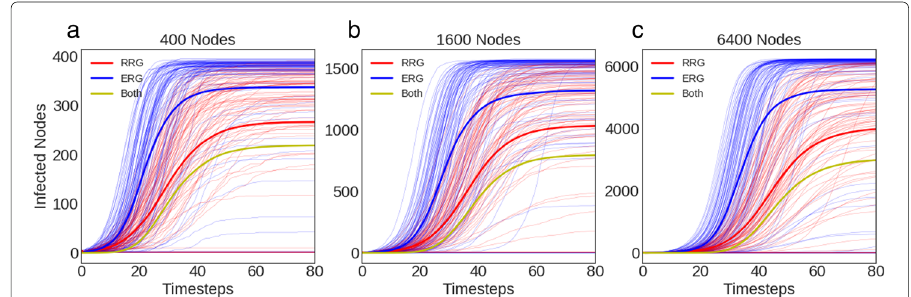
Fig. 8 Bi-modal branching of diffusion outcomes typically arise when the faster contagion has high dormancy and the slower contagion has low dormancy. These results are recorded across RRG-ERG pairings of different sizes (400, 1600, and 6400 nodes in ( a ), ( b ), and ( c ) respectively), demonstrating size invariance to the final diffusion depth. Parameters: τ A = 0.14, τ B = 0.02 and α = 3.0